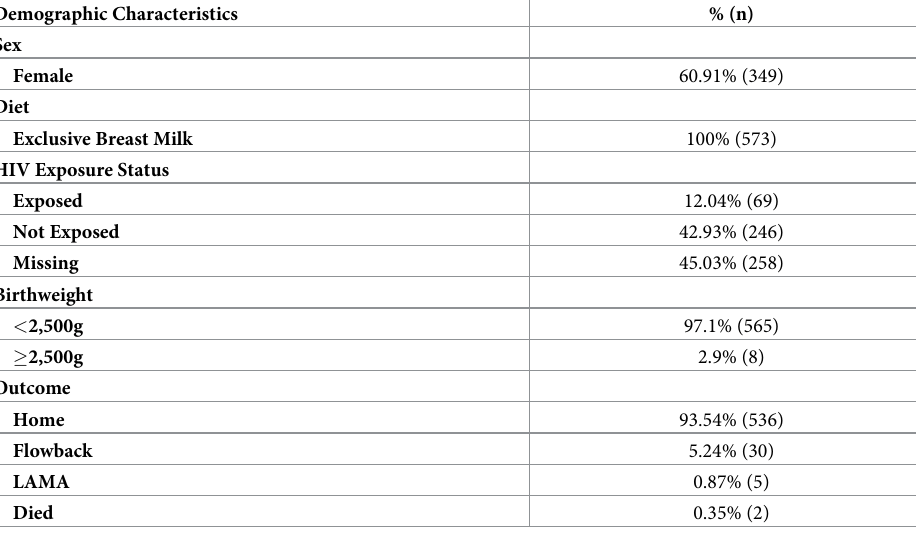
Table 1. Demographic characteristics of neonates (n =